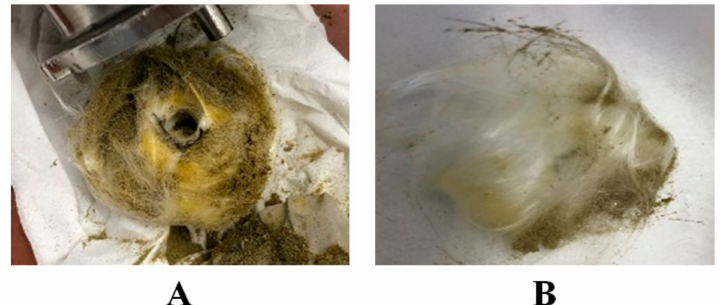
Figure 5. Schematic representation of glass wool after experimental setup A ( A ) and SFE Nottingham unit extraction ( B